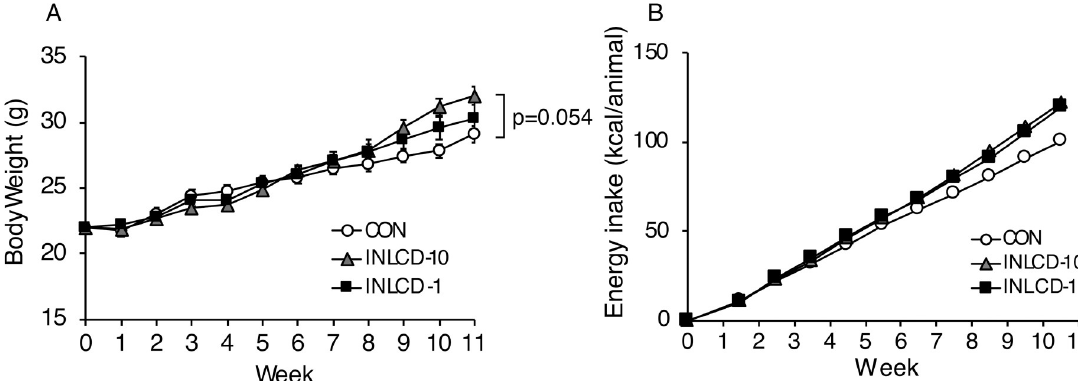
Fig 2. Effects of INLCD exposure on body weight and energy intake in exercise-trained mice. Mice were divided into three groups: those fed the control diet (CON), those fed an INLCD-10% (INLCD-10), and those fed an INLCD-1% (INLCD-1), and then reared for 12 weeks. Body weight (A) and total energy intake (kcal/mouse) (B) of mice during the first 11 weeks of the study are shown. Data are presented as means ± SEM, n = 8 per group. � , p < 0.05; �� , p < 0.01 vs. CON.